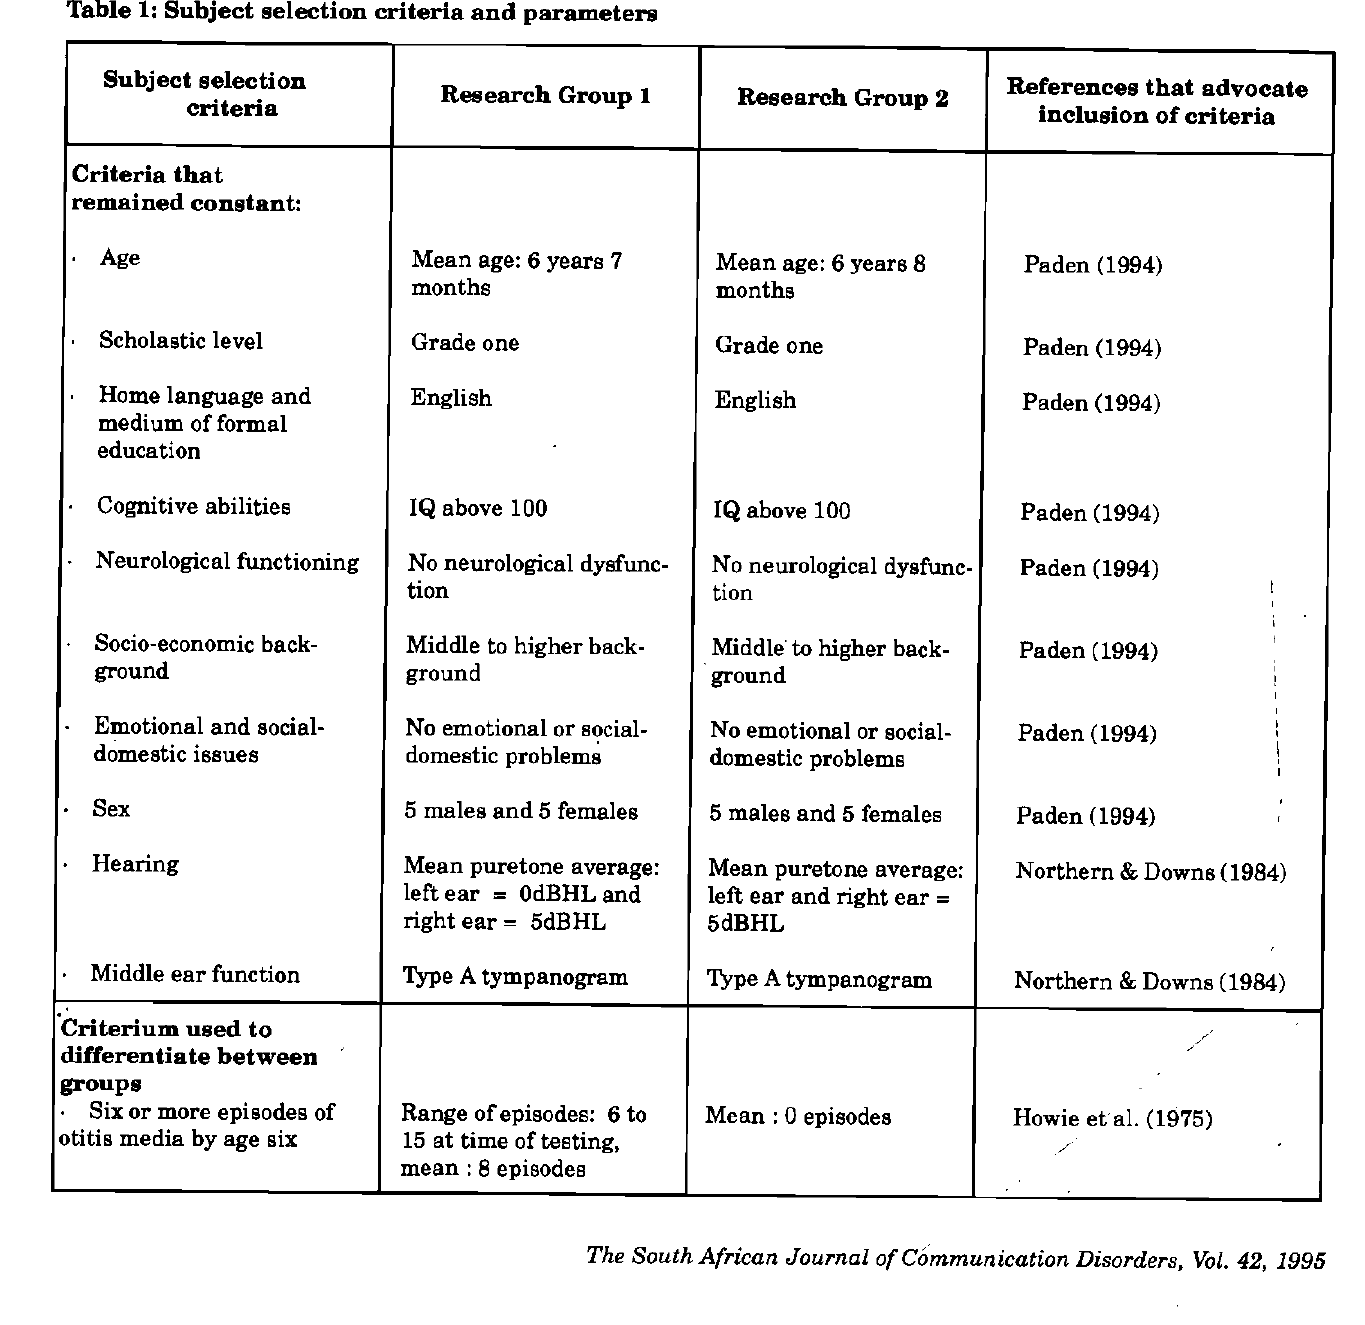
Table 1: Subject selection criteria and